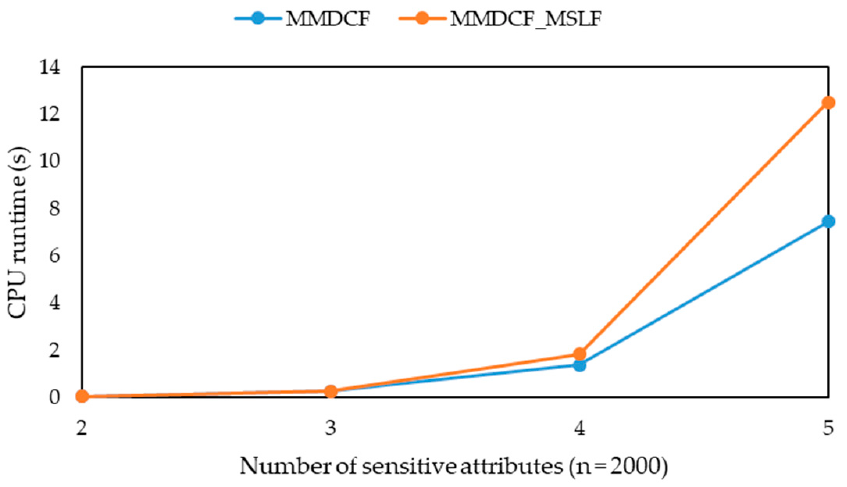
Figure 19. The CPU runtime of MMDCF and MMDCF-MSLF with different sensitive attribute numbers ( n = 2000).